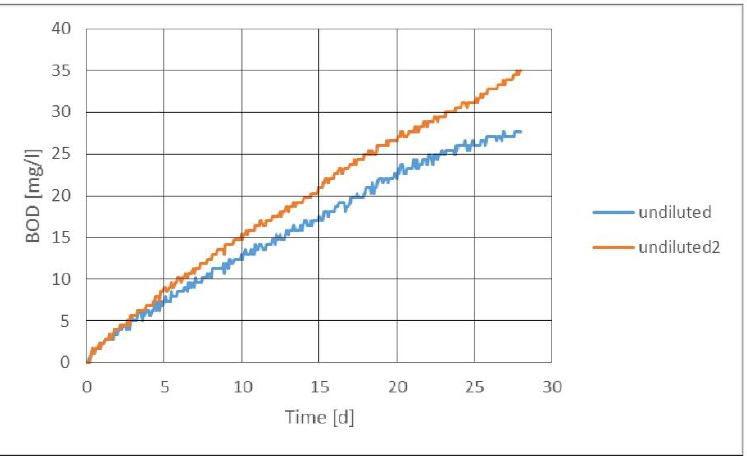
Figure 2. Graph of an undiluted sample with one replicate of WWP2 measured with BOD OxiTop for 28 days.